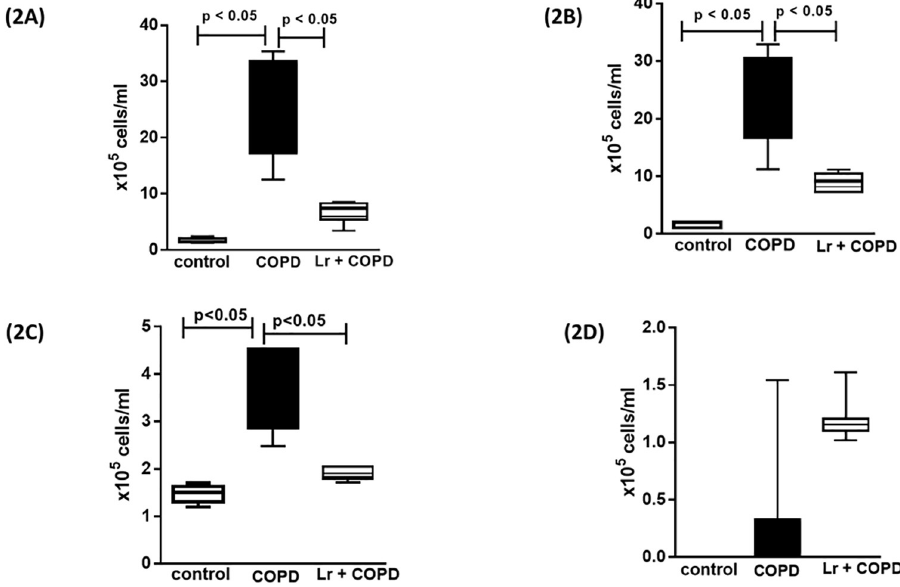
Fig 2. Leukocyte lung infiltration. After exposure of C57Bl/6 male mice to cigarette smoke and treatment with Lactobacillus rhamnosus ( Lr ), the total cells (2A) and inflammatory cells were counted (x10 5 ) in BALF in millimeters by the morphometric evaluations of cytospin preparations. Pulmonary inflammation was represented by the influx of specific leukocytes; neutrophil (2B), macrophage (2C), and lymphocytes (2D) in BALF fluid. All cell counts were obtained from the control, COPD and Lr + COPD groups. No significant difference between Lr group and control group (data not shown). Each plot represents mean ± SEM from 7 different animals. The experiments were performed in triplicate. Results were considered significant when p <